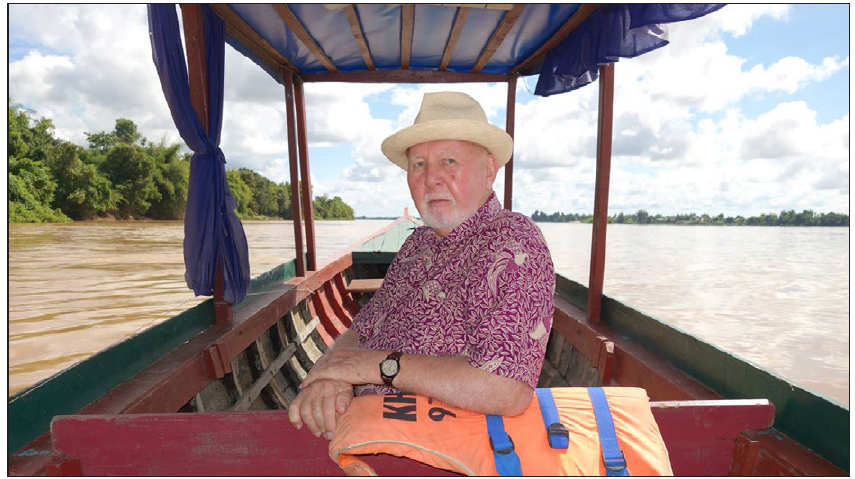
Figure 3: Ian Glover (Photo: Pia